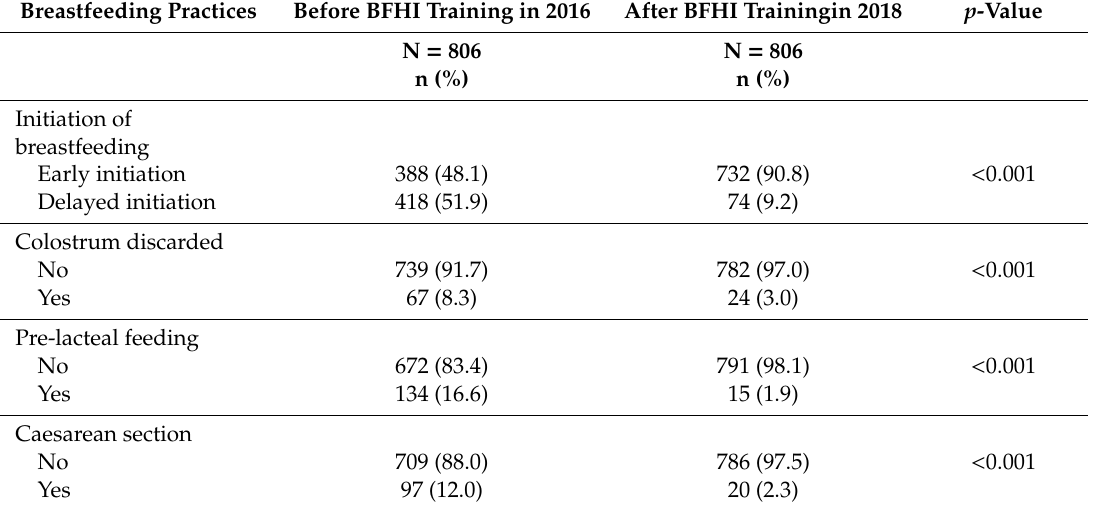
Table 2. Breastfeeding practices among mother–infant pairs before and after the BFHI training in Juba Teaching Hospital, South Sudan.